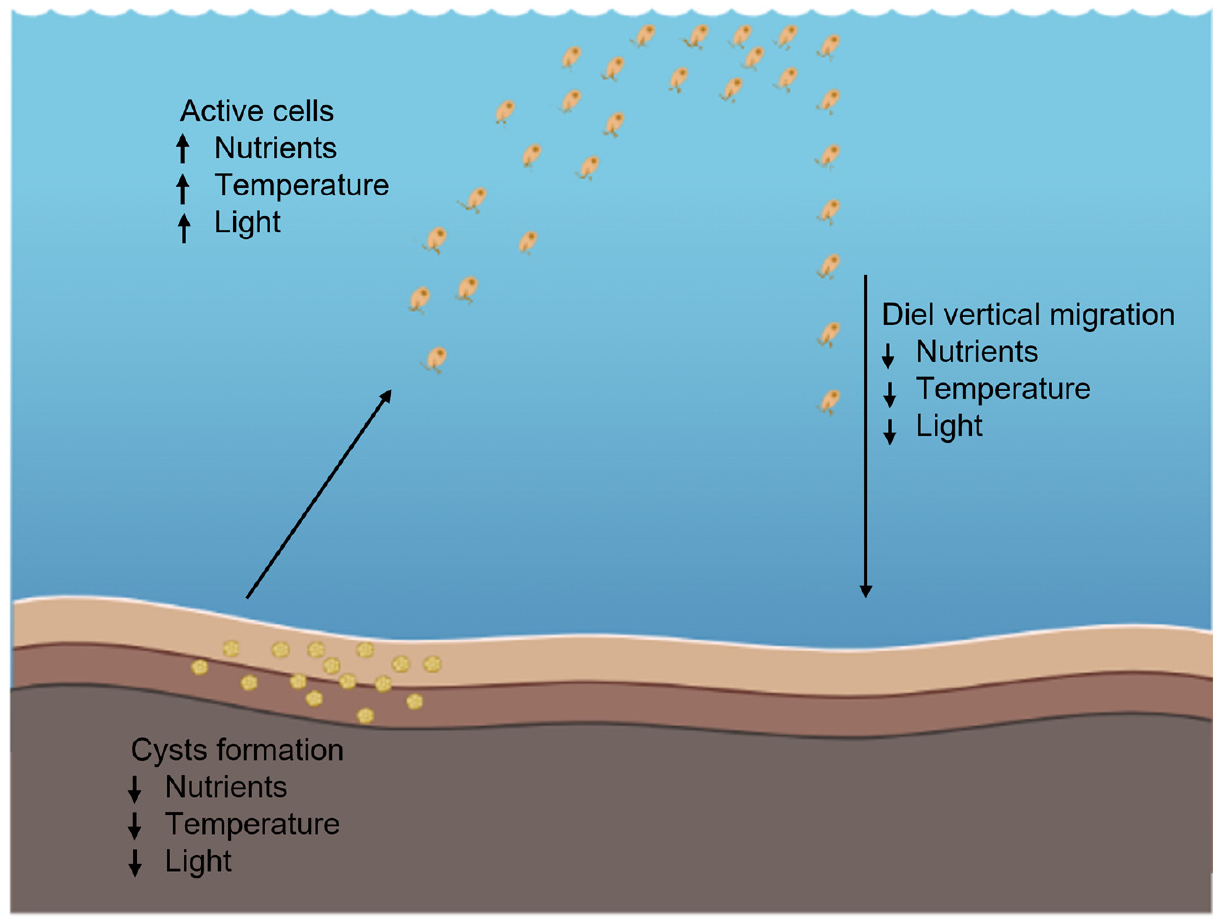
Figure 3. Schematic representation of H. akashiwo cyst formation. Light, temperature, and nutrients are key parameters to form benthic vegetative cyst or transfer cells into active stage. This image was created with BioRender (https://biorender.com/(accessed on 22 January 2023)). H. akashiwo showed no or very slow growth at 11 ◦ C; nevertheless, its cysts survived at 11 ◦ C in the dark for 650 days. Cyst survival decreased to 165 days in the dark at 25 ◦ C [59]. The cyst cells contain a significantly lower total lipid content compared to active cells. For a successful transition between these two stages, fatty acid composition plays a crucial role [26]. During this transition and under certain environmental conditions such as an abrupt change in temperature, salinity, biogenic elements content, and illumination, polyunsaturated fatty acids (PUFAs) are required to form photosynthetic membranes [61] and modify cellular and organelle membranes [62]. Neutral lipid reservoirs provide the required energy for algal motility